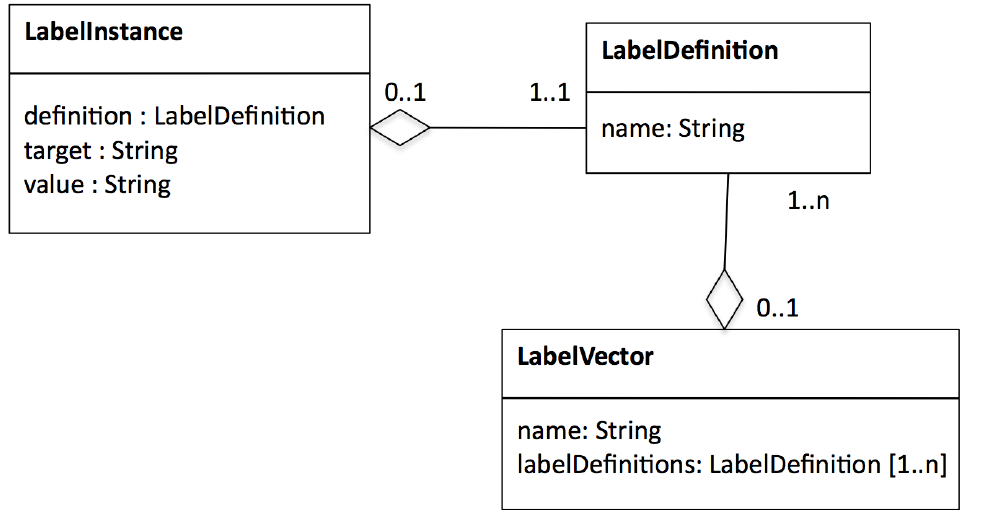
Figure 8. UML Class Diagram denoting information model of